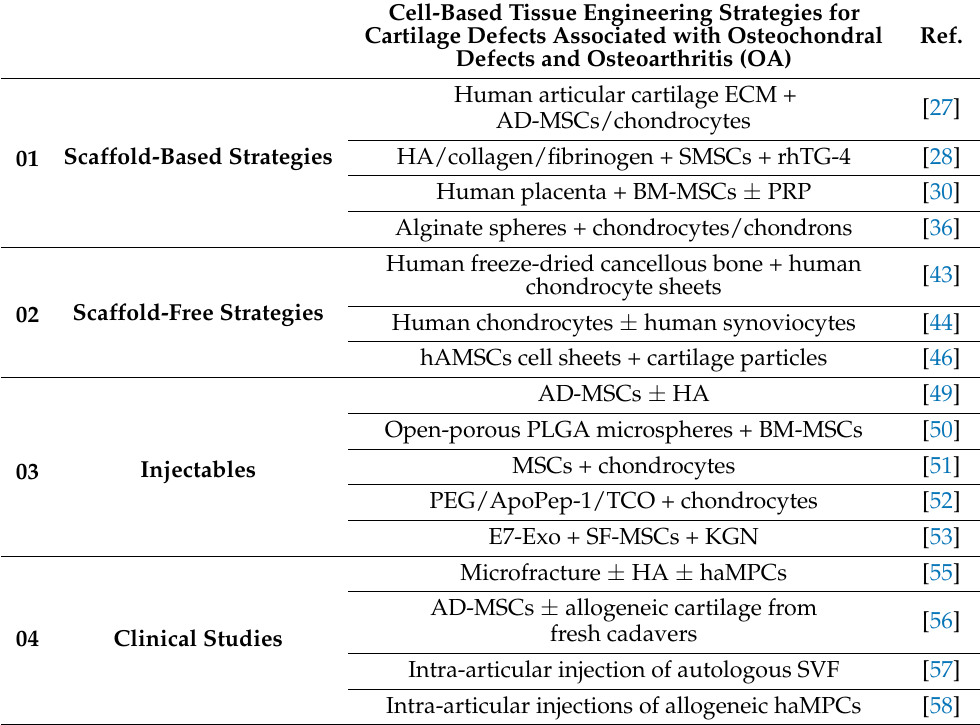
Table 2. List of studies on cell-based tissue engineering strategies for cartilage defects associated with osteochondral defects and osteoarthritis (OA). Cell-Based Tissue Engineering Strategies for Cartilage Defects Associated with Osteochondral Defects and Osteoarthritis (OA)